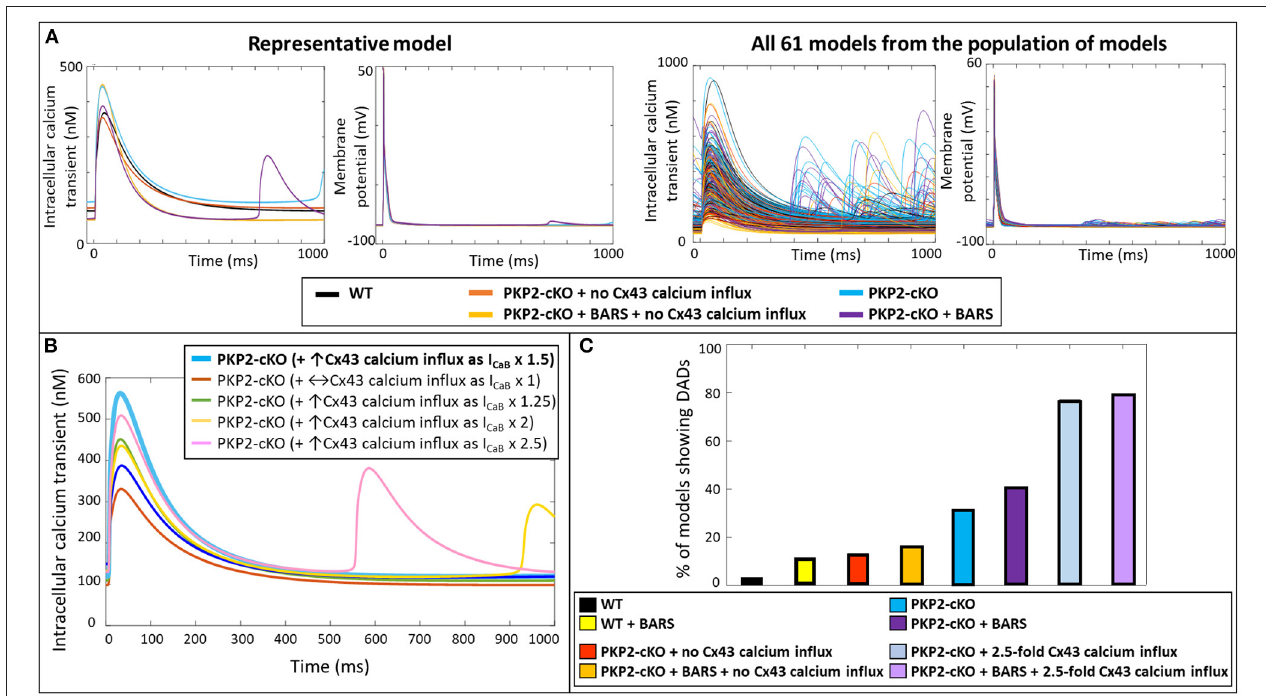
FIGURE 4 | (A) Top: Representative calcium transient and membrane potential traces of the wildtype (WT) and PKP2-cKO model, with and without BARS and the PKP2-cKO model with no Cx43 hemichannels-mediated calcium influx, with and without BARS. Please note the occurrence of a DAD-like event in the presence of PKP2-cKO under BARS (purple line) but absence of these events without Cx43 hemichannels-mediated calcium influx. Bottom: Calcium transient and membrane potential traces for all models from the population of models in the five situations described above. (B) Calcium transient in PKP2-cKO models with various increments of Cx43 hemichannel-mediated calcium influx showing the occurrence of DADs from I CaB x 2. (C) Percentage of models showing DADs under control (wildtype, WT) conditions with and without BARS, PKP2-cKO conditions with no Cx43 hemichannel-mediated calcium influx with and without BARS, PKP2-cKO conditions (1.5-fold increase in Cx43 hemichannel-mediated calcium influx) with and without BARS, and PKP2-cKO conditions in addition of an even larger increase in Cx43 hemichannel-mediated calcium influx (2.5-fold) with and without